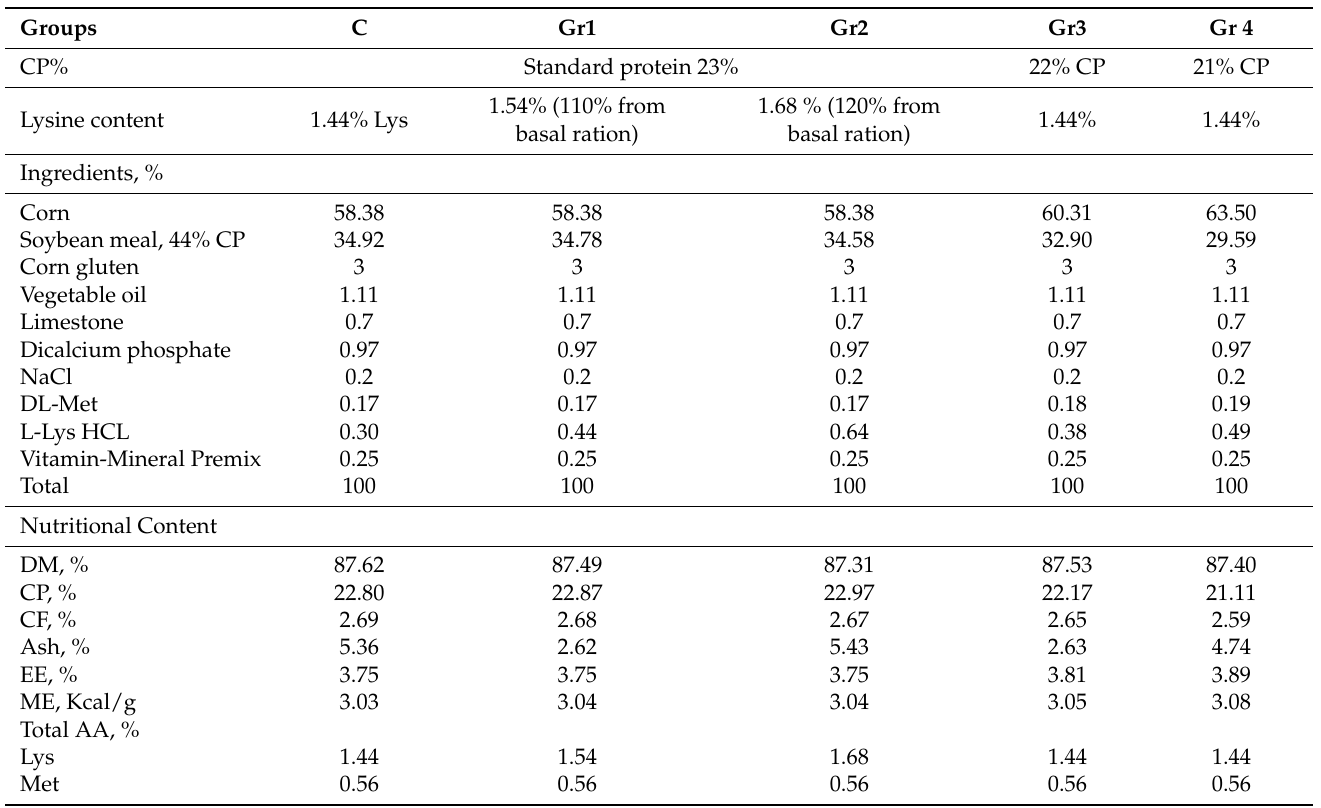
Table 1. The composition of the experimental diets and proximate chemical analysis during the starter